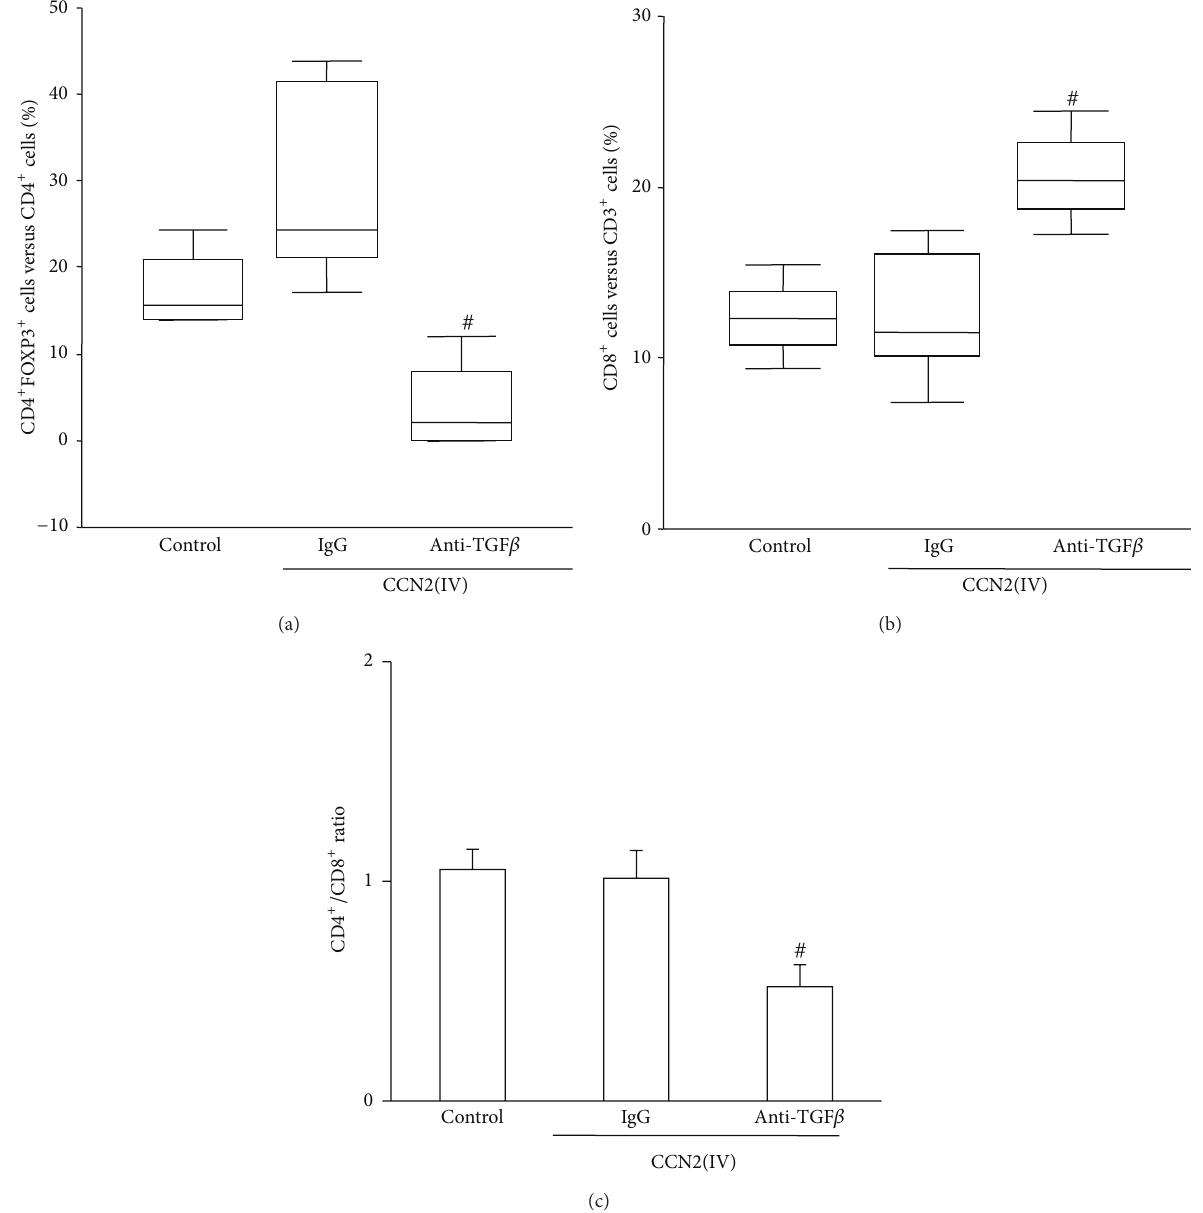
Figure 5: TGF- 𝛽 blockade modulates circulating immune cells. Lymphocyte populations were analyzed in blood samples by flow cytometry. (a) represents the percentage of CD4 + FOXP3 + cells among CD4 + T cells. (b) shows the percentage of cytotoxic (CD8 + ) T lymphocytes among total CD3 + T lymphocytes. The CD4 + /CD8 + ratio is shown in (c) (mean ± SEM of 5 mice per group). # 𝑃 < 0.05 versus